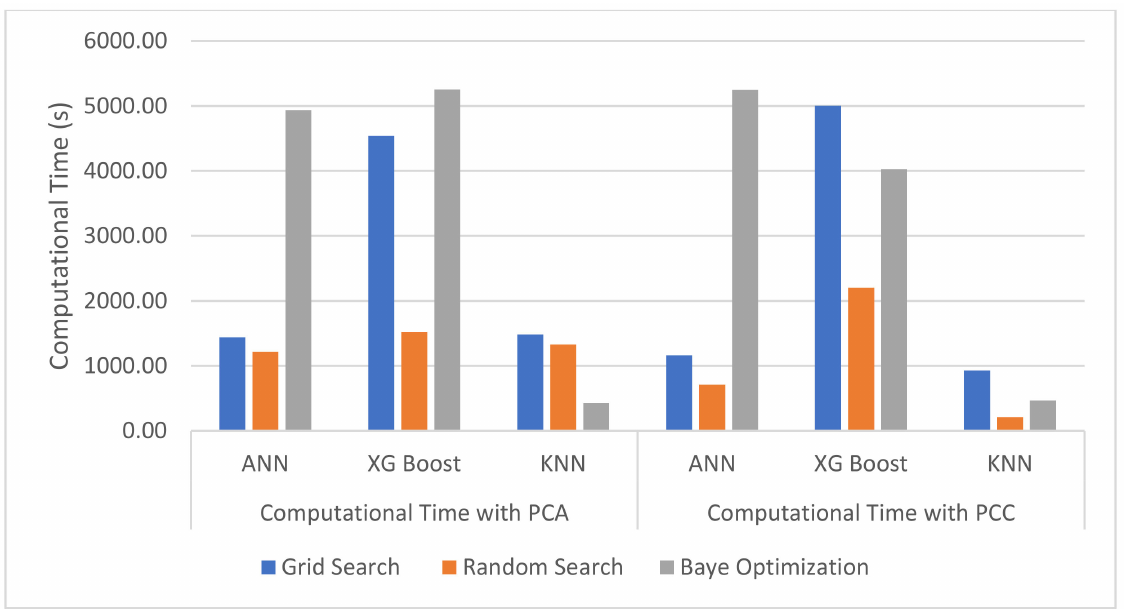
Figure 18. Computation Time for Each Hyperparameter Optimization Method in PCA and